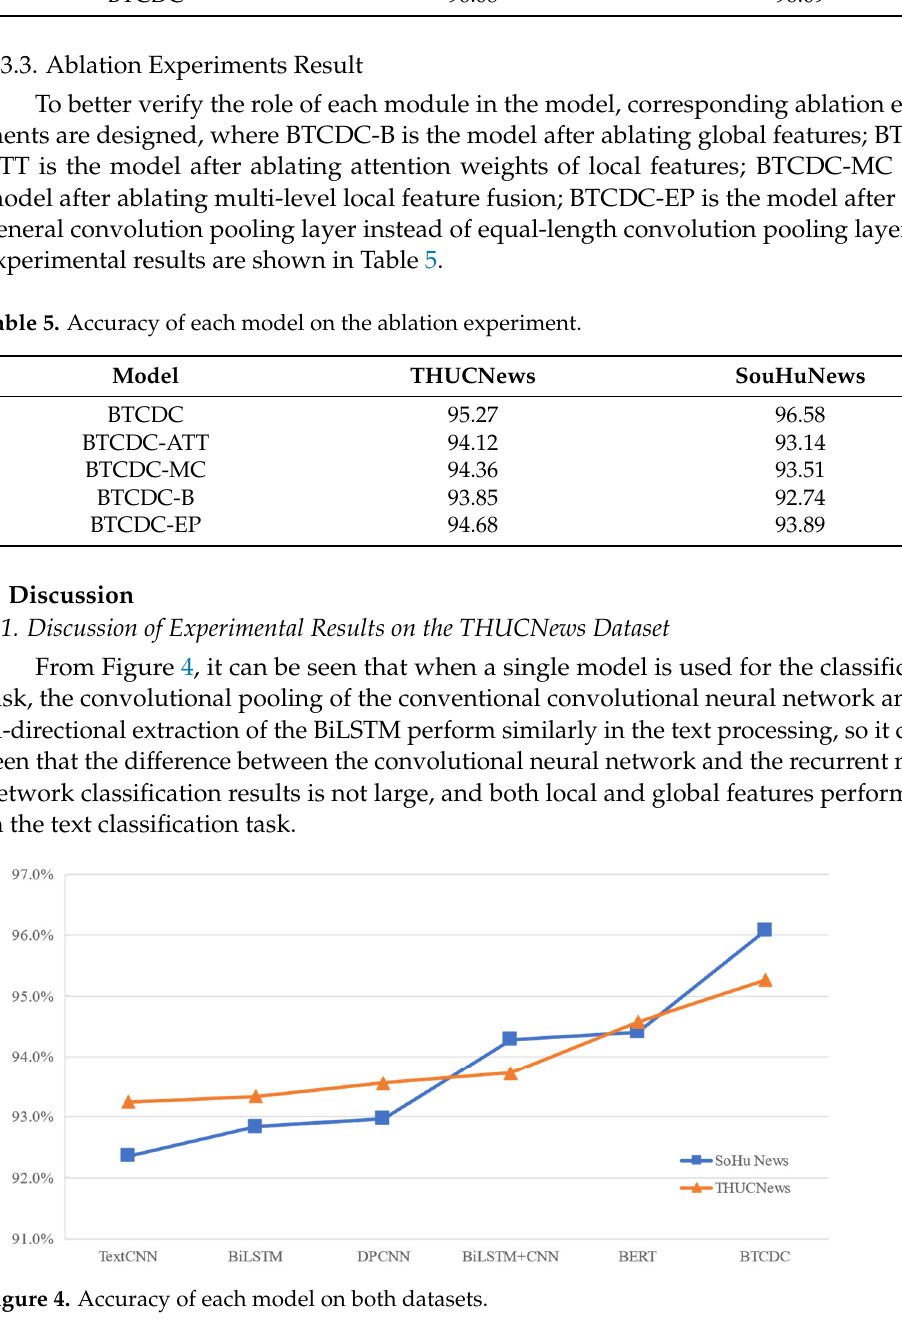
Figure 4. Accuracy of each model on both